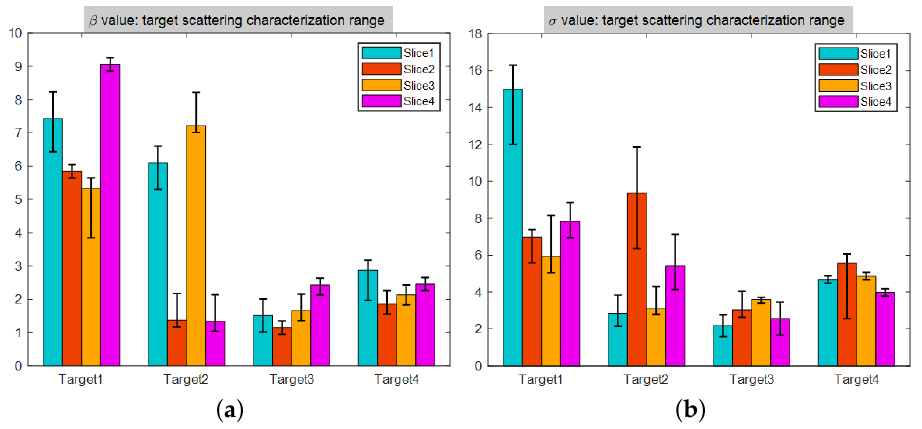
Figure 16. The range of β and σ value for target scattering characterization: ( a , b ) β , σ histogram: Four kinds of target with four slices (Target1–Target4 represent warehouse, tank, structure, special structure